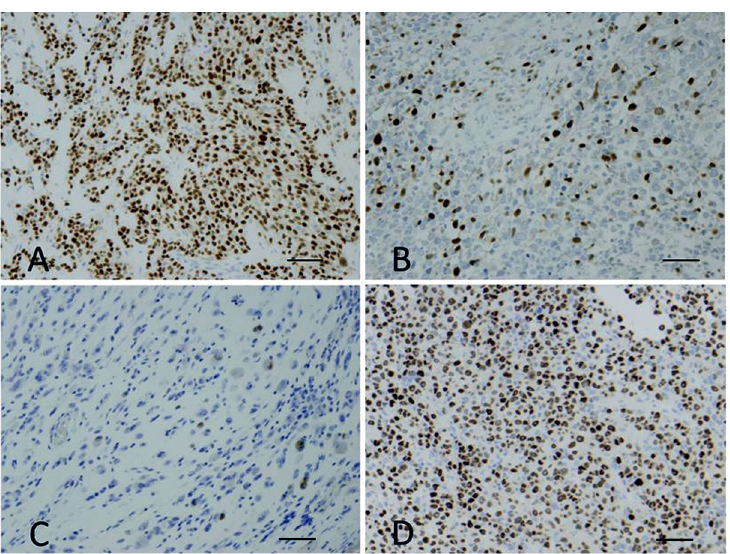
Fig 2. (A) Immunostaining for Myf4 in histological sections of a t +ARMS, showing a positive nuclear staining (brown cells) in more than 90% of cells. (B,C and D) Immunostaining for Myf4 in histological sections of a ERMS, immunostained for Myf4, varying from scattered cells ( < 20%) to more than 40% and 70% of cells respectively (160x, scale bar 120 μ m).